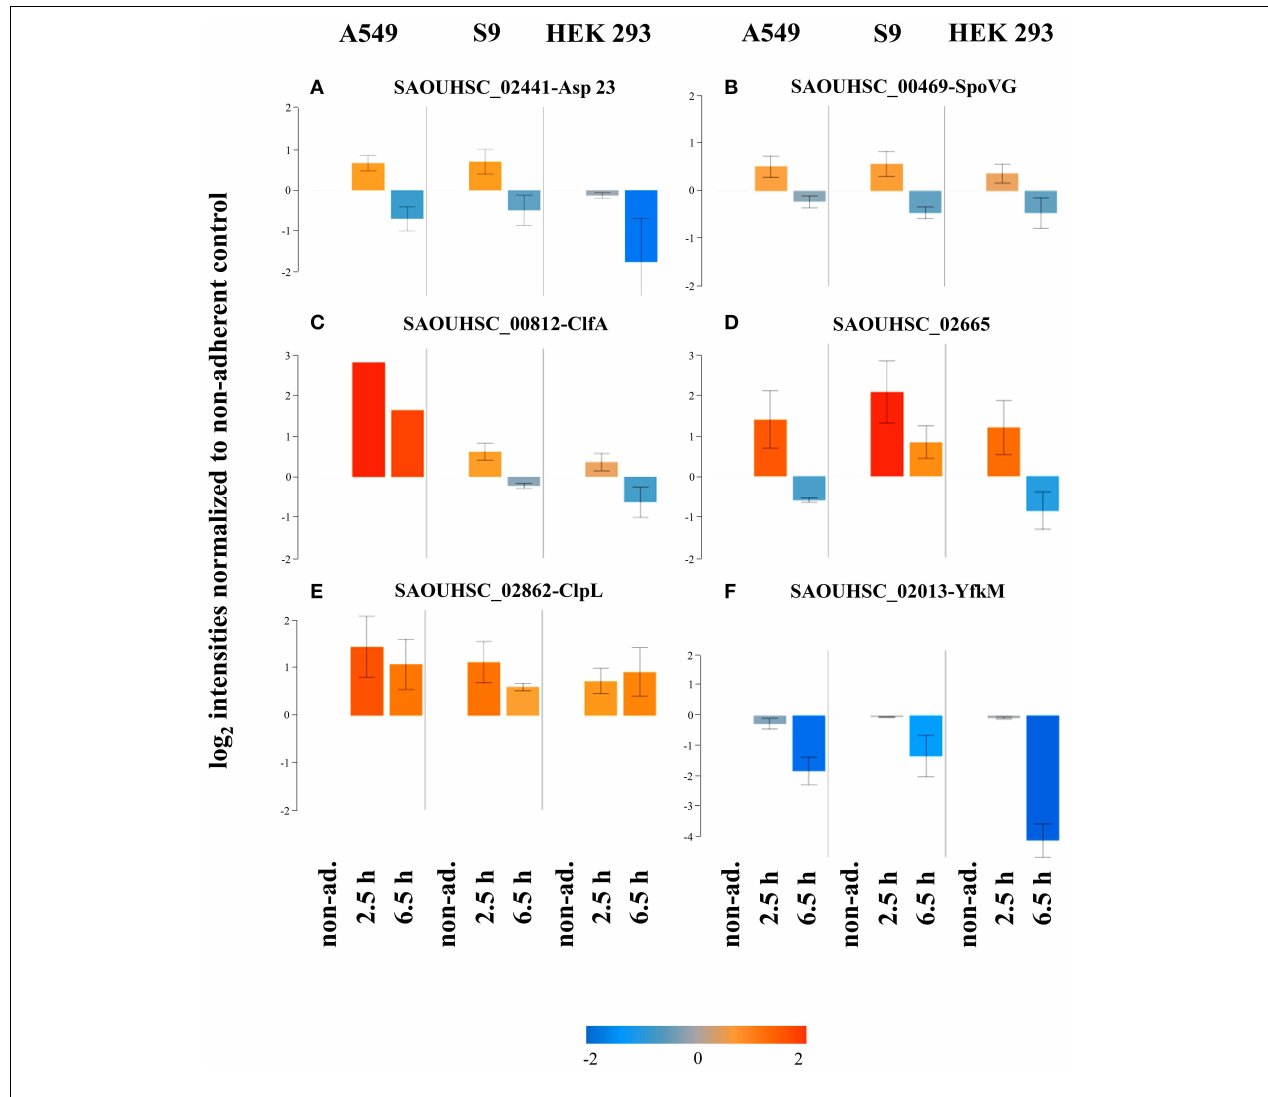
FIGURE 7 | Activation of SigB following internalization. Average values of log 2 intensities from three biological replicates each for non-adherent bacteria as well as 2.5h and 6.5h p.i. are depicted for six proteins encoded by members of the SigB regulon. Blue spots indicate lower